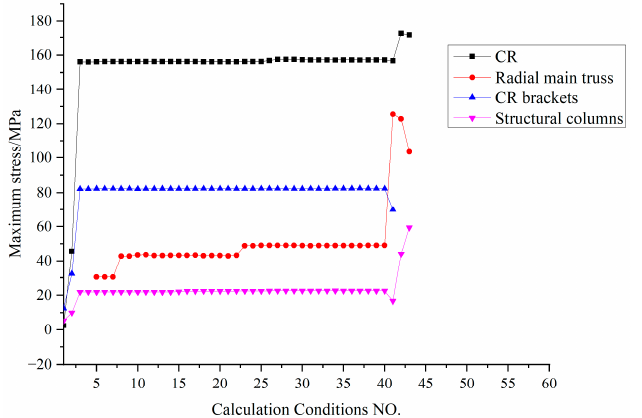
Figure 51. Maximum stress variation curve of four types of components under various calculation conditions (MPa).